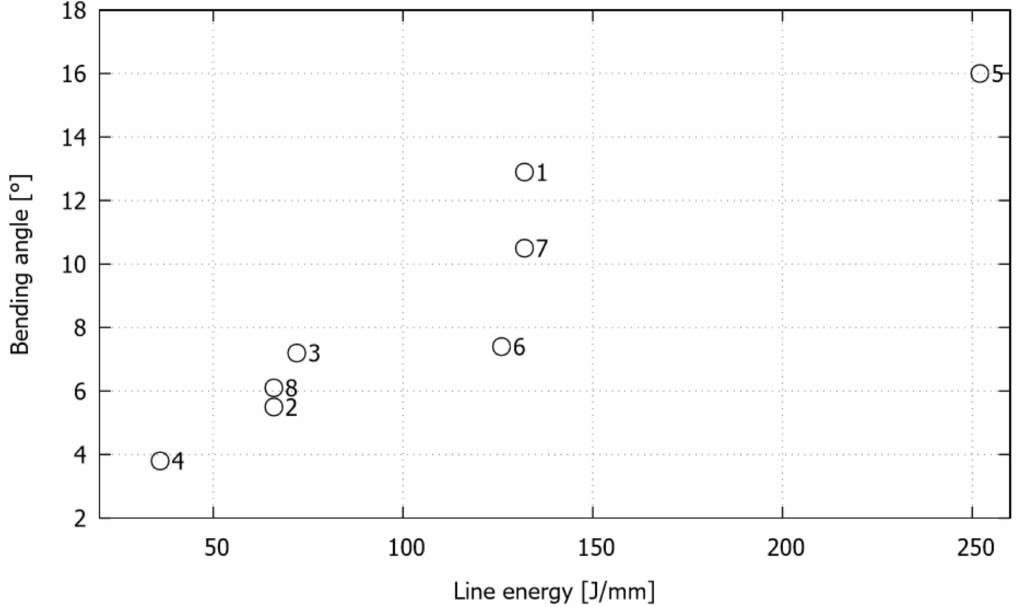
Figure 9. Single S-shape scanning path: experimental (average) final bending angle in terms of line energy for the studied